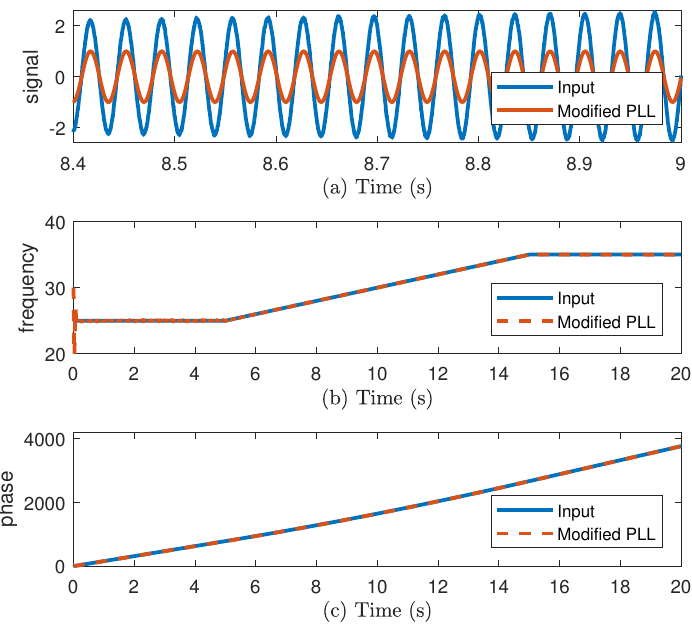
Figure 5. ( a ) Input and PLL sinusoidal output v f , ( b ) frequency, and ( c )